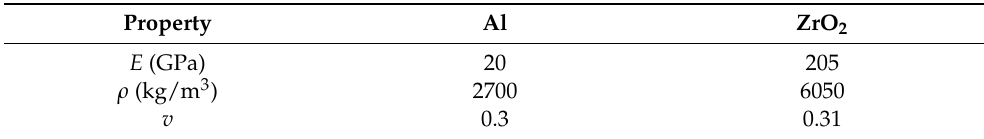
Table 2. Material properties of aluminum and zirconia.